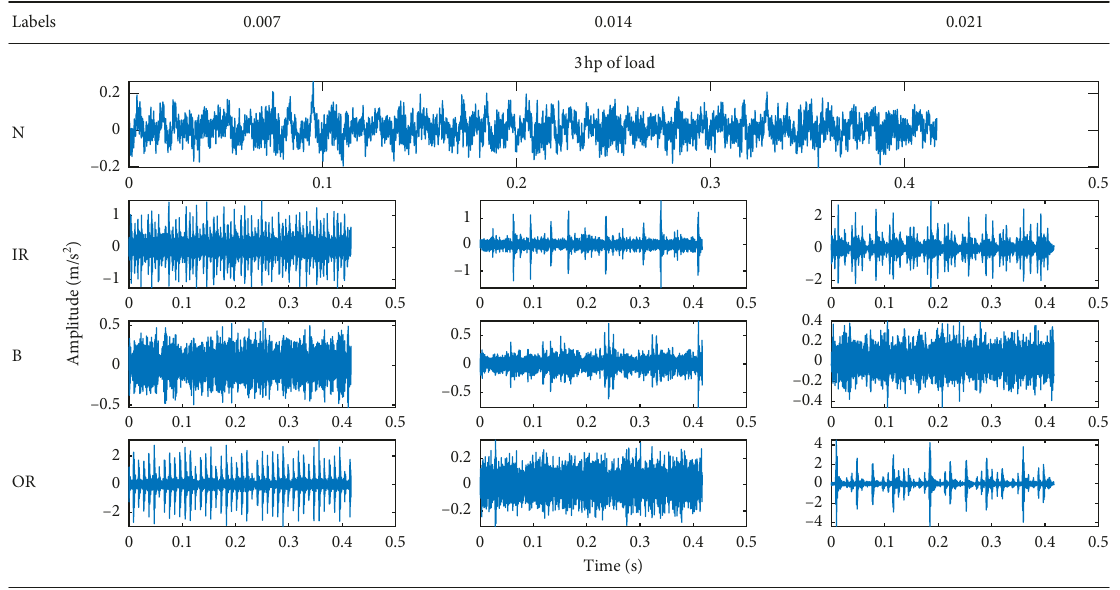
Figure 10: Time-domain graph of the original signal when the load is 3hp. Table 2: Numerical analysis of the healthy bearing and faulty bearing with a fault diameter of 0.007 inch.